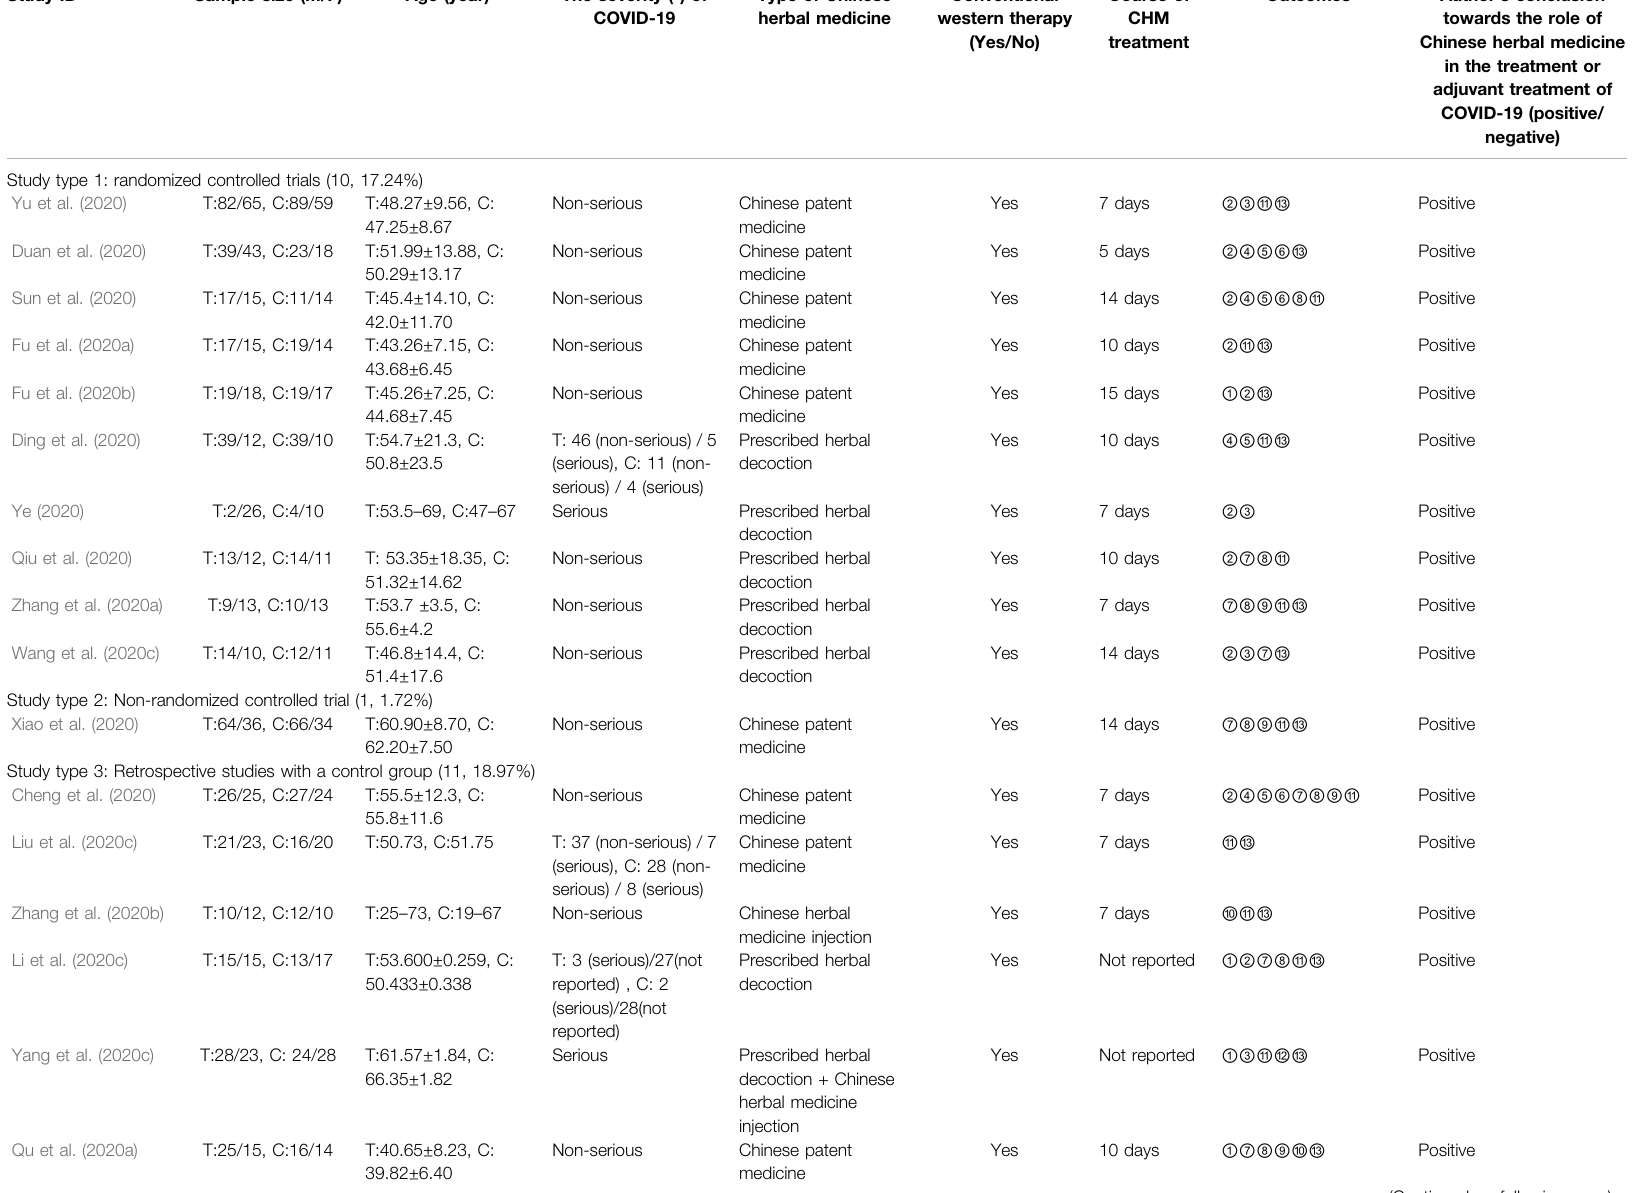
TABLE 1 | The characteristics of included studies of Chinese herbal medicine for